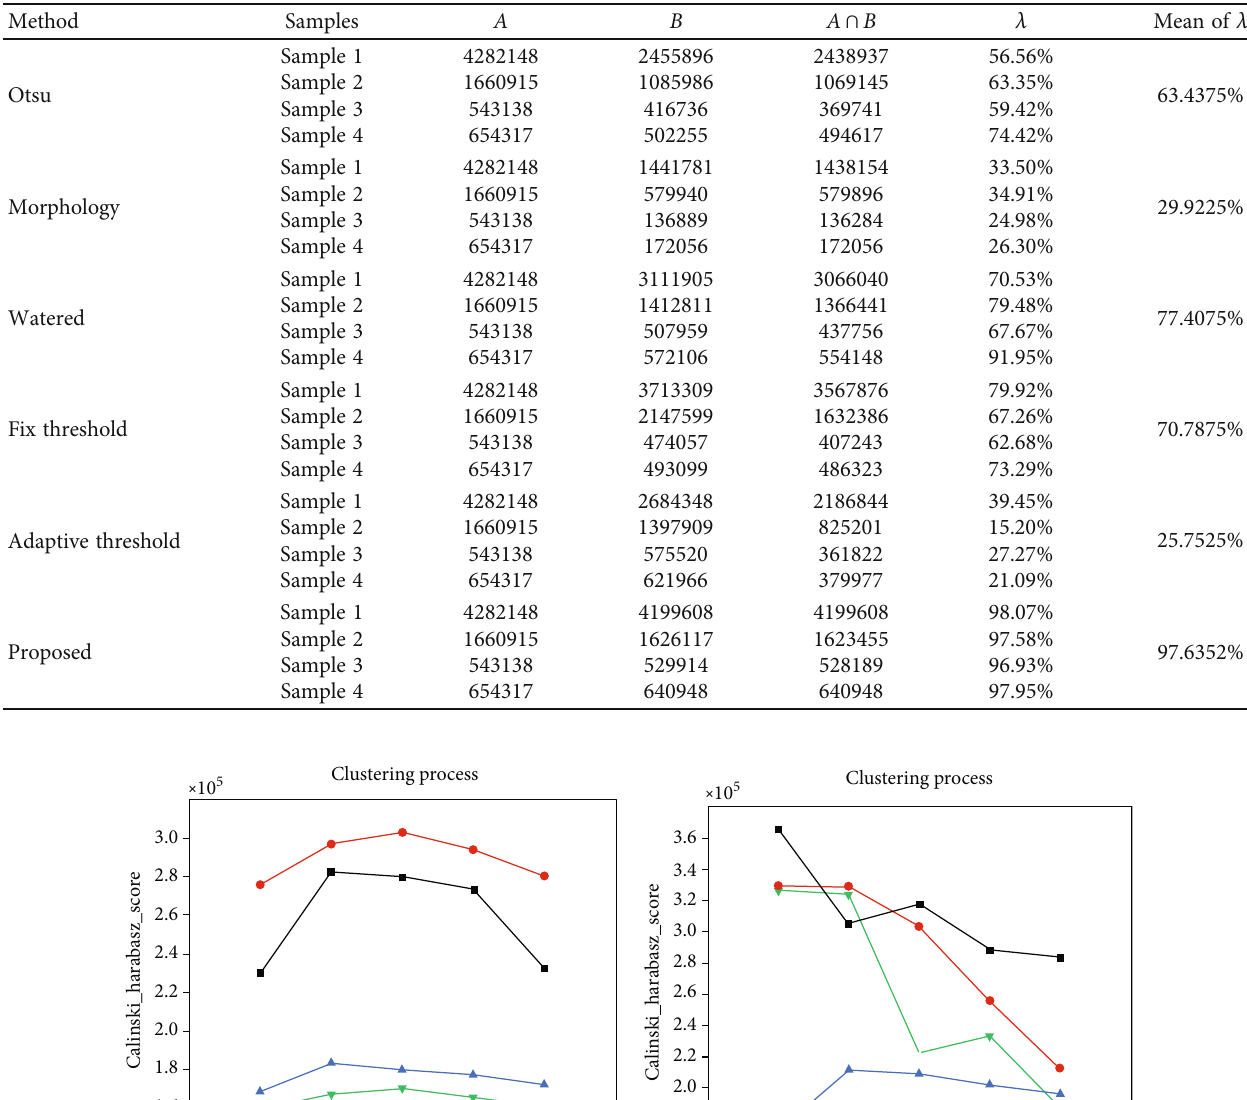
Table 2: Segmentation accuracy rate λ of the main body.